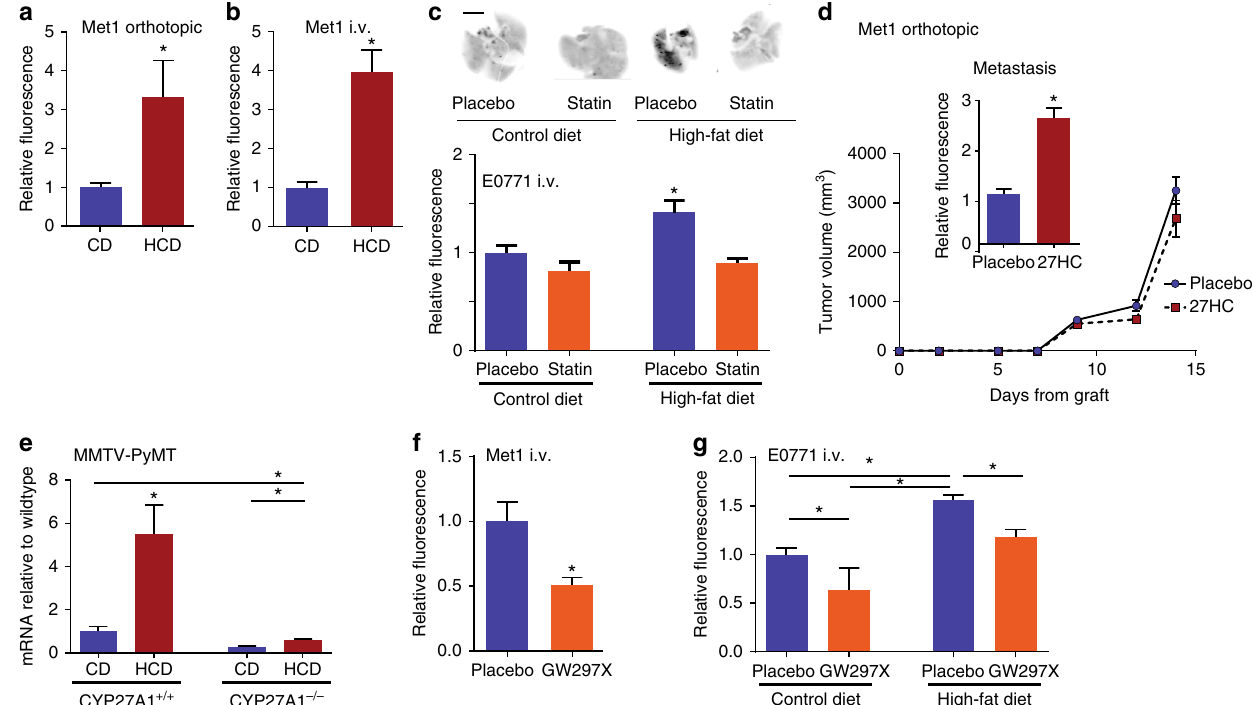
Fig. 1 27HC is a biochemical mediator of the effects of obesity and elevated cholesterol on breast cancer metastasis. a A high-cholesterol diet (HCD) increases spontaneous metastasis of murine ER-negative Met1 cells ( N = 10 each). b Mice fed a high-cholesterol diet (HCD) exhibit increased lung colonization of i.v. grafted Met1 mammary tumors (CD N = 7, HCD N = 8). c A high-fat diet (HFD) increases lung colonization of murine E0771 i.v. grafts in APOE3 mice (i.v. graft of cells). Pretreatment for 7 days prior to the graft and continued treatment throughout the study with daily placebo or atorvastatin (statin, 40 mg/kg) by oral gavage reduced metastatic colonization. Representative images of iRFP-expressing E0771 colonies (depicted as black ) within the lungs are presented above quanti fi ed data (control diet (CD) placebo N = 11, statin N = 7, HFD placebo N = 8, statin N = 7, scale bar indicates 5 mm). d Chronic administration of exogenous 27-hydroxycholesterol (27HC) increases spontaneous metastasis to the lung as measured by relative fl uorescence ( inset ) without impacting growth rate of the primary tumor ( N = 3). e Metastatic effects of a HCD in MMTV-PyMT mice requires conversion to 27HC by CYP27A1 (wild-type CD N = 8, HCD N = 14, CYP27A1 − / − CD N = 3, HCD N = 9). Quantitative RT-PCR for PyMT transcript within the lung is presented in the graph and used to quantify metastasis since its expression should be restricted to mammary epithelial cells. f Chronic treatment with a small molecule inhibitor of CYP27A1, GW273297X (GW297X) decreases colonization of lung tissue from Met1 i.v. grafts ( N = 4 each). g Lung